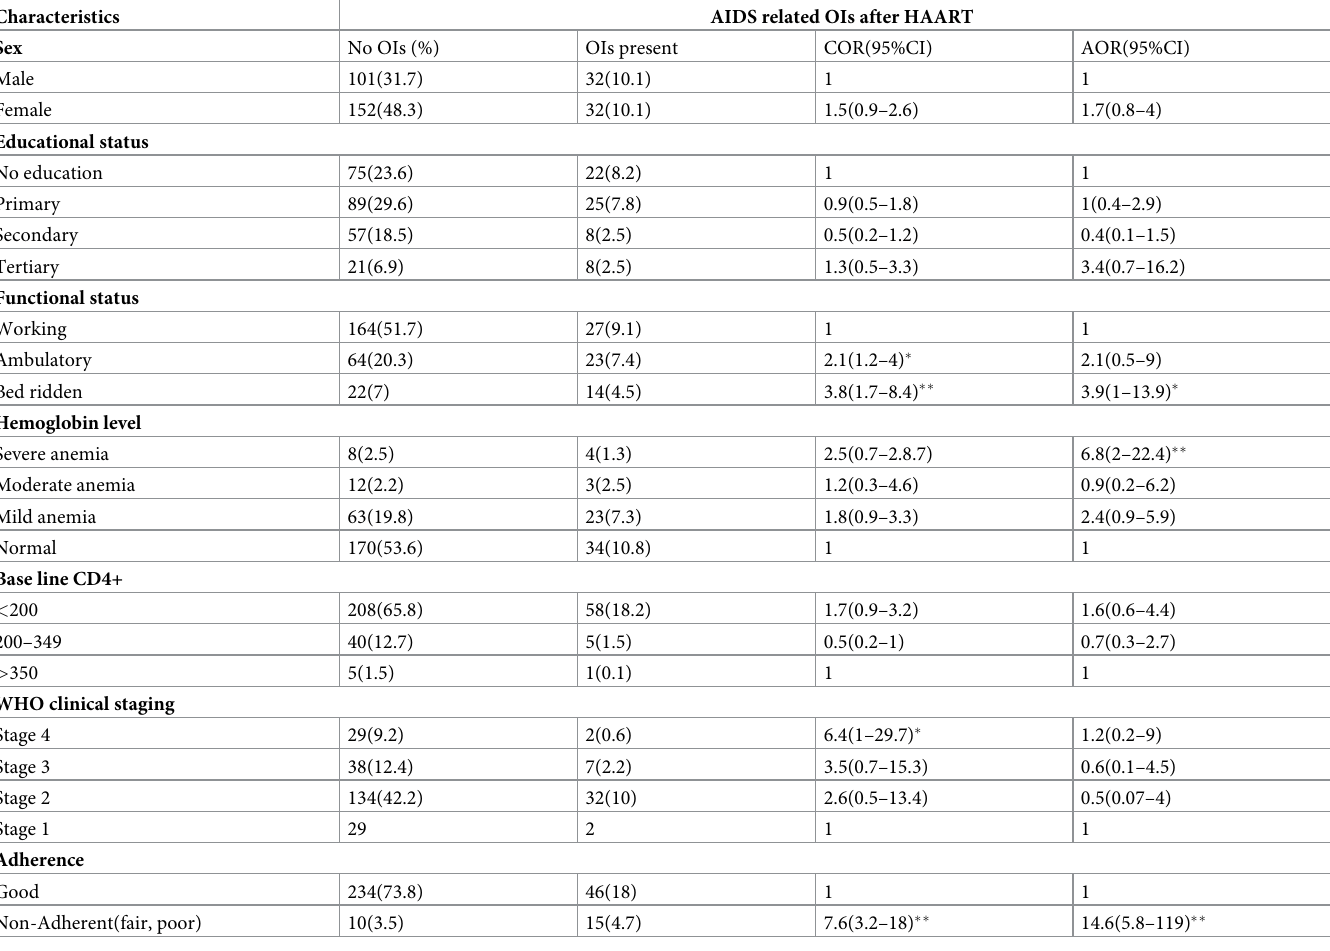
Table 4. Incidence of HIV related OIs after HAART in relation to potential predictor variables, at Ayder Referral Hospital, Mekelle, Ethiopia. (n = 317) January 2009 to May 2012.